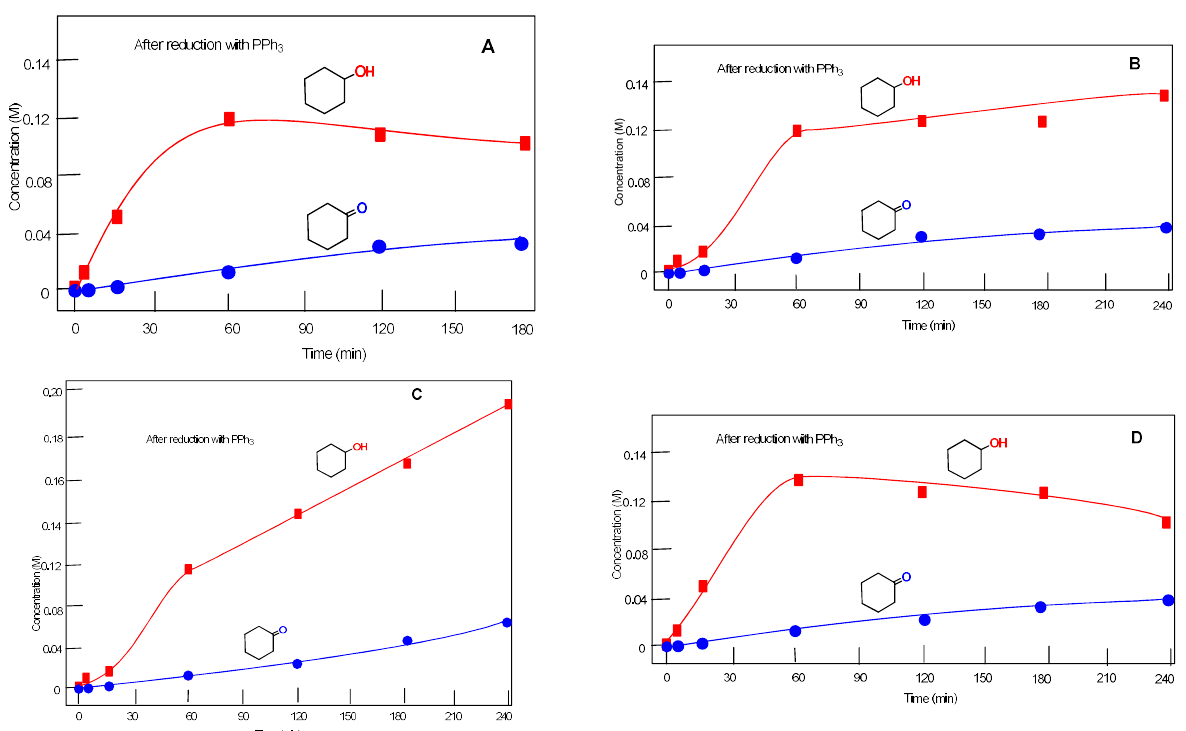
Figure 7. Accumulation of cyclohexanol and cyclohexanone in oxidation of cyclohexane (0.46 M) with hydrogen peroxide (2.0 M, 50% aqueous) catalyzed by complex 1 ( A ); maximum total yield of sum of oxidation products 30%, TON = 276); complex 2 ( B ); maximum total yield 35%, TON = 322); complex 3 ( C ); maximum total yield 50%, TON = 460); complex 4 ( D ); maximum yield 33%, TON = 304) in MeCN at 50 °C. Conditions: solvent acetonitrile, 50 °C, concentration of catalyst was (5 × 10 –4 M). Concentrations of cyclohexanone and cyclohexanol were determined after reduction of the aliquots with solid PPh 3 .